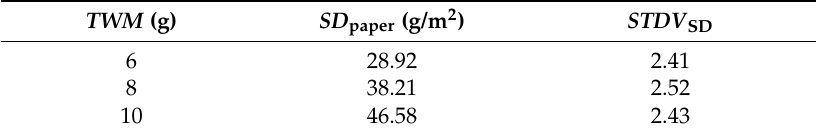
Table 1. Characteristics of the different paper layers used in the